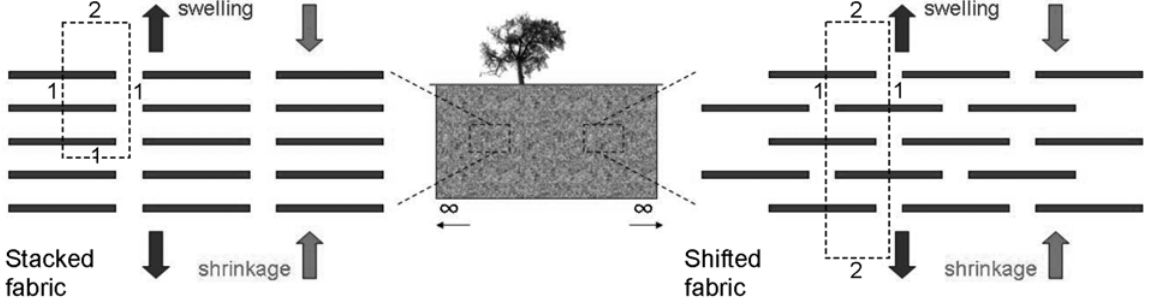
Fig. 4 – Particle arrangements: (a) Parallel particle arrangement and (b) Shifted particle arrangement. The dotted lines indicate the schematic representations of the computational domains for numerical models with symmetry (1) and prescribed (2) boundary conditions.